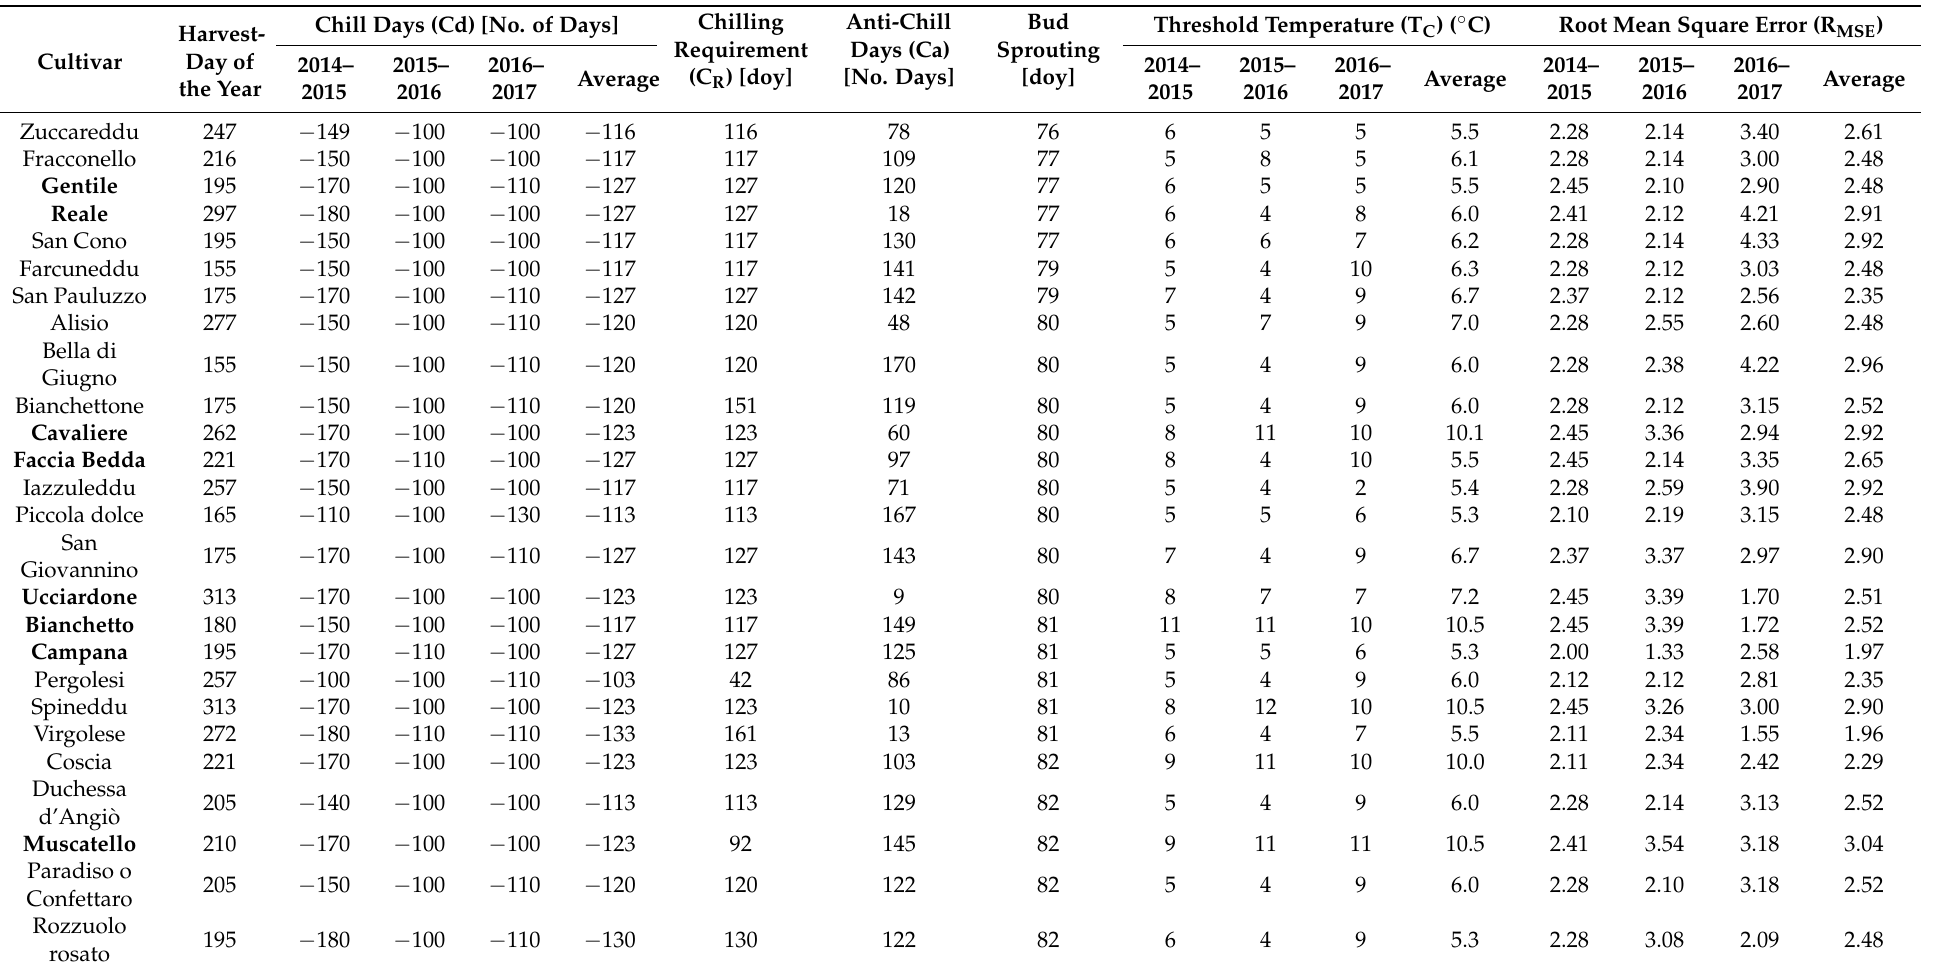
Table 3. Main phenological stages employed in the Chill Day model for the pears cultivated at the Experimental field 2 (850 m a.s.l.). Rows were ordered according to the bud